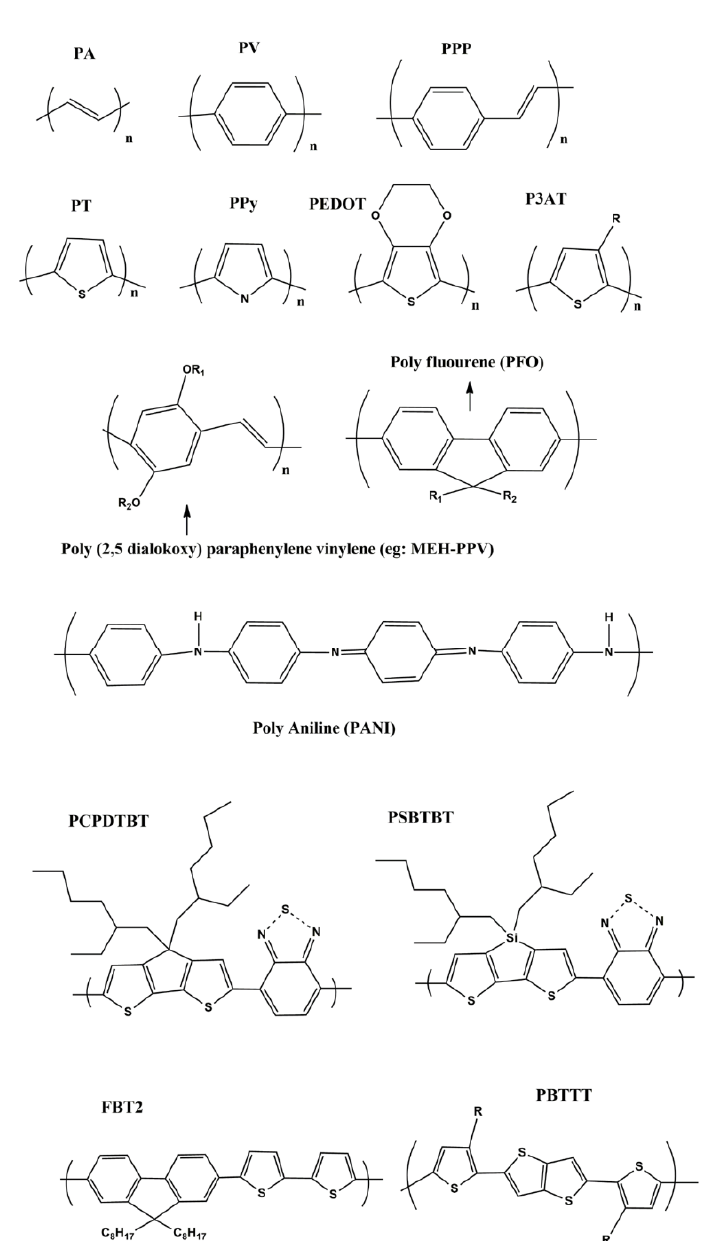
Figure 1. Shows various semi conducting polymers from first to third generations: PA-poly acetylene; PV-poly paraphenylene vinylene; PPP-poly para phenylene; PT-poly thiophene; PPy-poly pryrrole; PEDOT-poly ethylene dioxythiophene; P3AT-poly 3(alkyl) thiphene (R-Alkyl group); PCPDBT-poly(2,6-[4,4-bis-(2-ethylhexyl) 4 H -cyclopenta (2,1- b ;3,4- b 1 )dithiophene- alt -4,7-(2,1,3-benzothiadiazole)]; PSBTBT-Poly [(4,4 ′ -bis(2-ethylhexyl)dithieno[3,2- b :2 ′ ,3 ′ - d ]silole)-2,6-diyl-alt-(2,1,3-benzothiadiazole)-4,6-diyl]; FBT2-poly(9,9-dioctylflourene- co -bithiophene); PBTTT-poly(2,5-bis(3-alkylthiophen-2-yl)thieno[3,2- b ]thiophene respectively. Even though there have been various SPN for bio-imaging and drug delivery applications [69], little is known for the applications in PTT, PDT, combined PTT/PDT, photo-immuno and photo-radio therapy. Thus, it is very important to have an overall look at their recent developments.